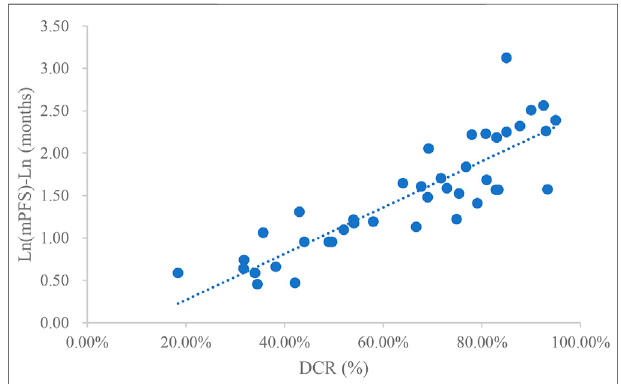
FIGURE 14 | Linear fi tting results for ORR and ln (mPFS).